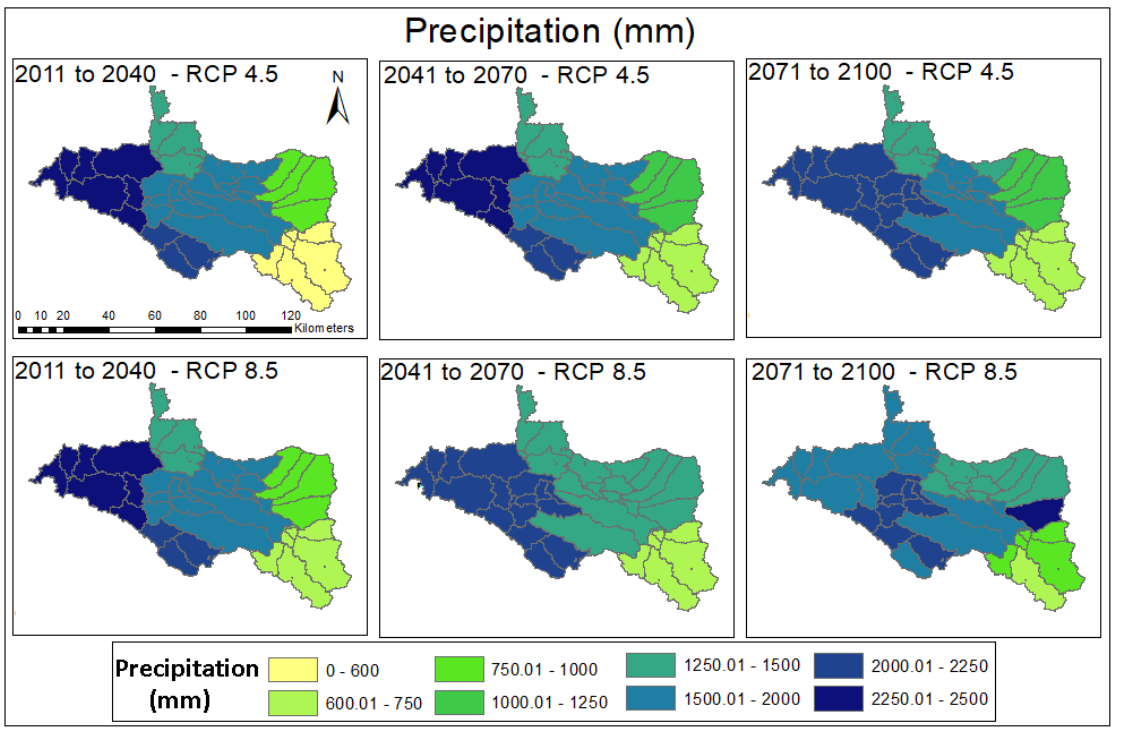
Figure 9. Spatial distribution of rainfall for near, mid-, and far future of RCP 4.5 and 8.5 emission scenarios